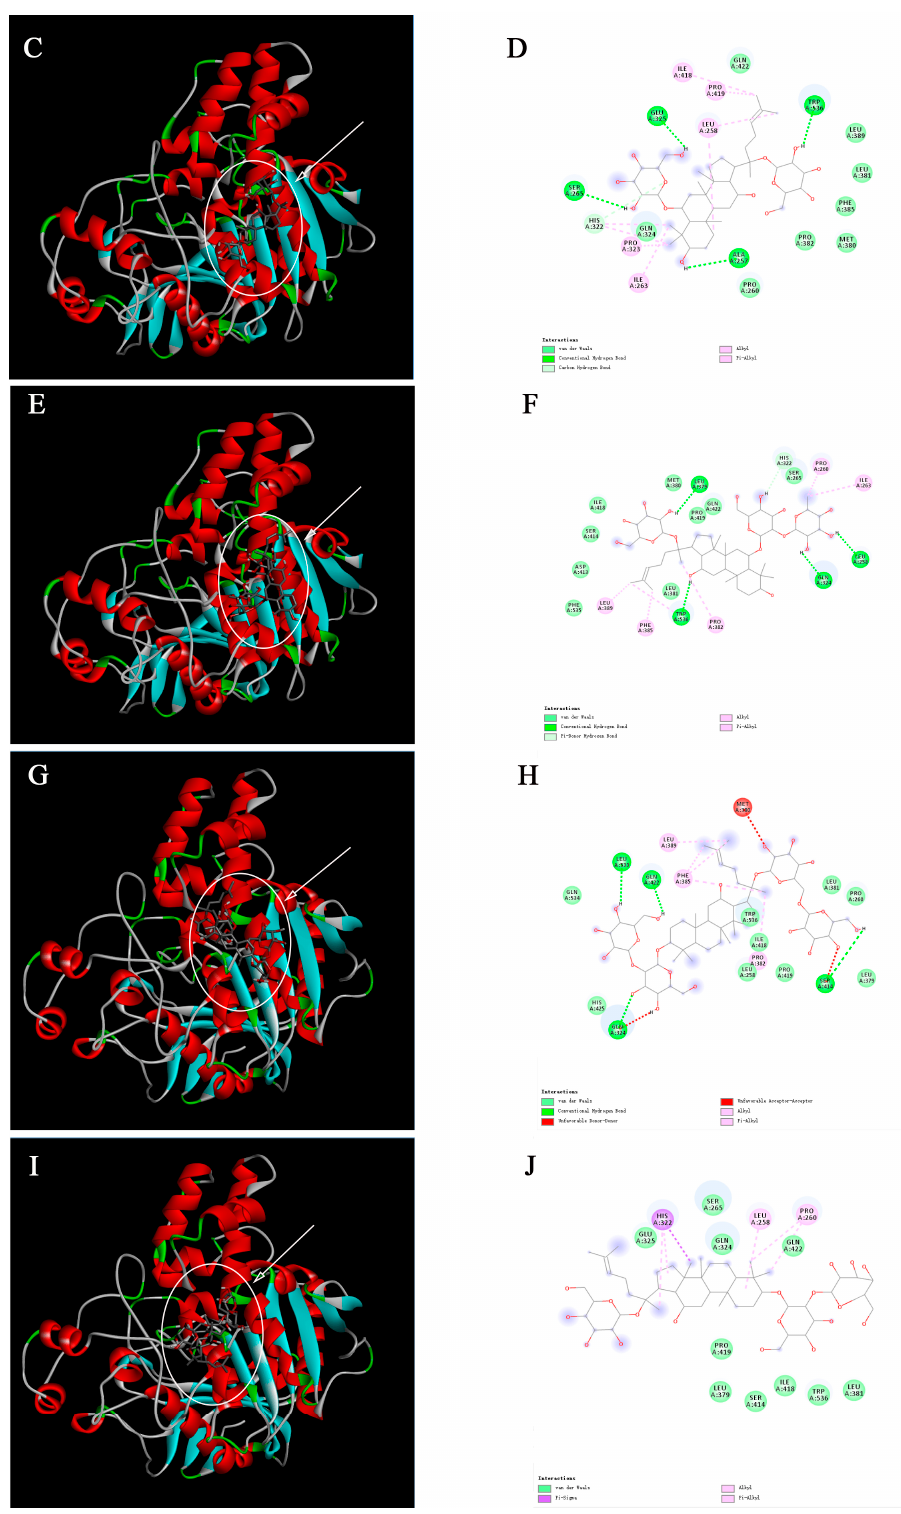
Figure 5. Molecular docking mode and interactions between hCE2 (shown in cartoon representation and colored structure) and notoginsenoside R 1 , ginsenoside Rg 1 , Re, Rb 1 , and Rd (indicated by arrow), respectively. Three-dimensional illustrations show the interactions of hCE2 with notoginsenoside R 1 ( A ), ginsenoside Rg 1 ( C ), Re ( E ), Rb 1 ( G ), and Rd ( I ). Two-dimensional diagrams display interactions of notoginsenoside R 1 ( B ), ginsenoside Rg 1 ( D ), Re ( F ), Rb 1 ( H ), and Rd ( J ) in the active sites of